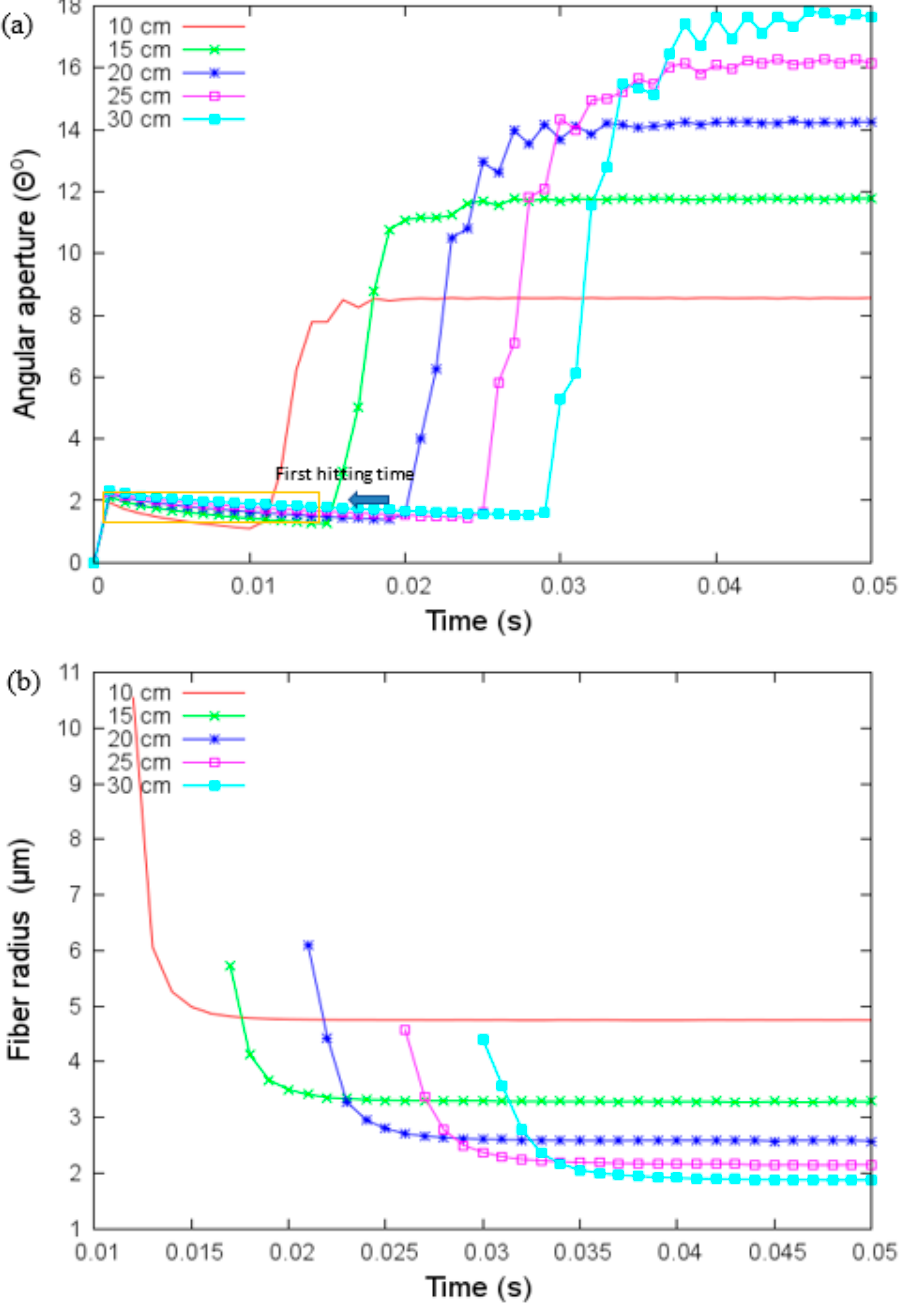
Figure 5. ( a ) Angular aperture versus time and ( b ) fiber radius versus time for different values of the collector’s distance under parameters given in Table 3. The first hitting time occurs when the jet touches the collector.